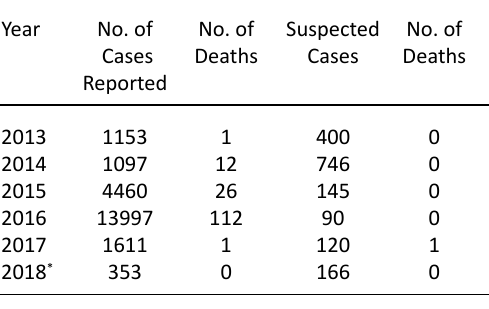
Table 2. Hepatitis E cases in India from 2013- 2018 based on Hospital